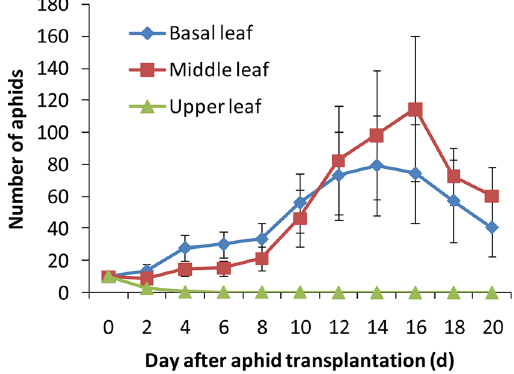
Figure 3. The number of cucurbit-specialized aphids (mean ± SE) on upper, middle and basal leaves from 6-month-old cotton plants.